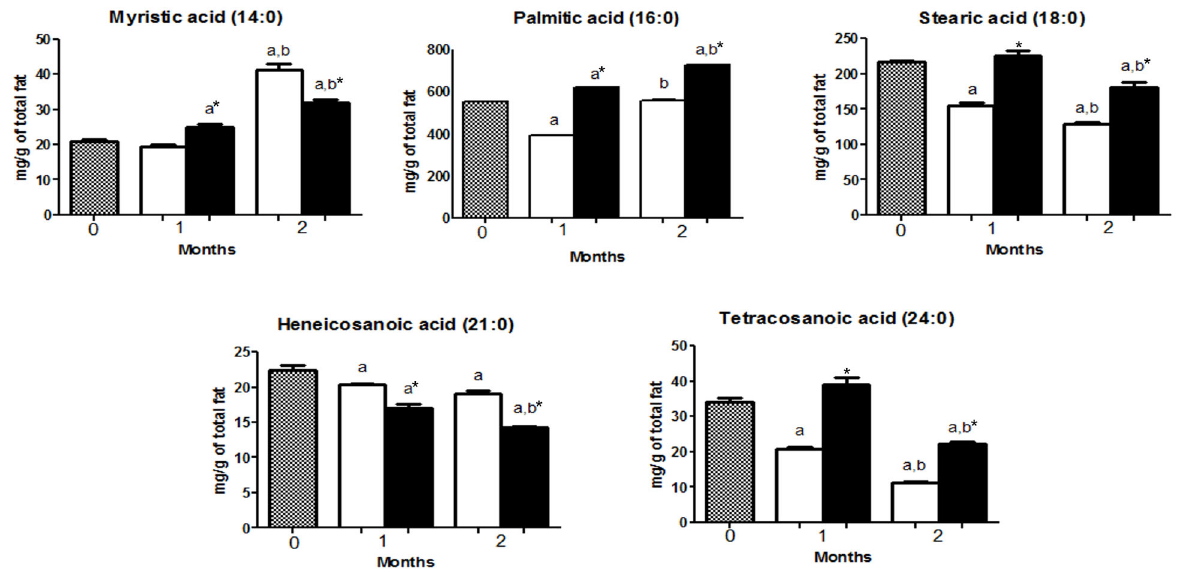
Figure 2. Saturated fatty acid (SFA) composition in the gastrocnemius muscle of mice at 0 (before starting the diets, gray bars) or fed with a high-carbohydrate diet (HCD, white bars) or high-fat diet (HFD, black bars) for 1 or 2 months. The concentrations of SFA are reported as means ± SE. *P o 0.05 compared to HCD group (Student ’ s t -test). a P o 0.05 compared to time 0; b P o 0.05 compared to 1 month (one-way The fi nal body weight was 45.8 ± 1.4 g for HCD group and 45.0 ± 2.2 g for HFD group after 1 month, and 51.0 ± 1.9 g for HCD group and 50.6 ± 1.5 g for HFD group after 2 months.